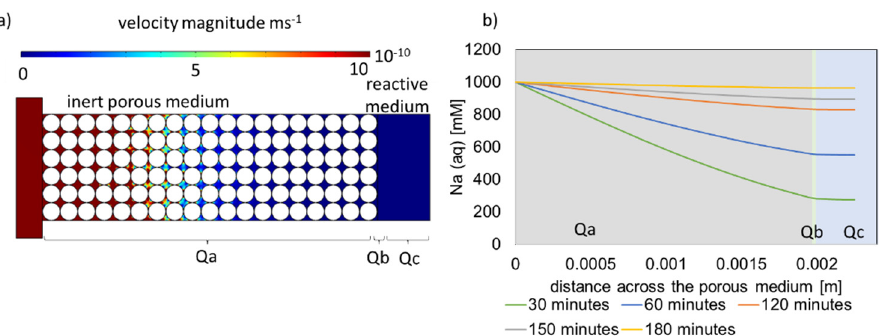
Figure 3. ( a ) 2D velocity map in the microfluidic device simulated using COMSOL Multiphysics (the upper limit of the scale bar was set at 10 × 10 − 10 m s − 1 for a better visualization of the velocities in the inert porous medium); ( b ) simulated concentration of total aqueous sodium across the reactor using OpenGeosys-6#Phreeqc as function of time.